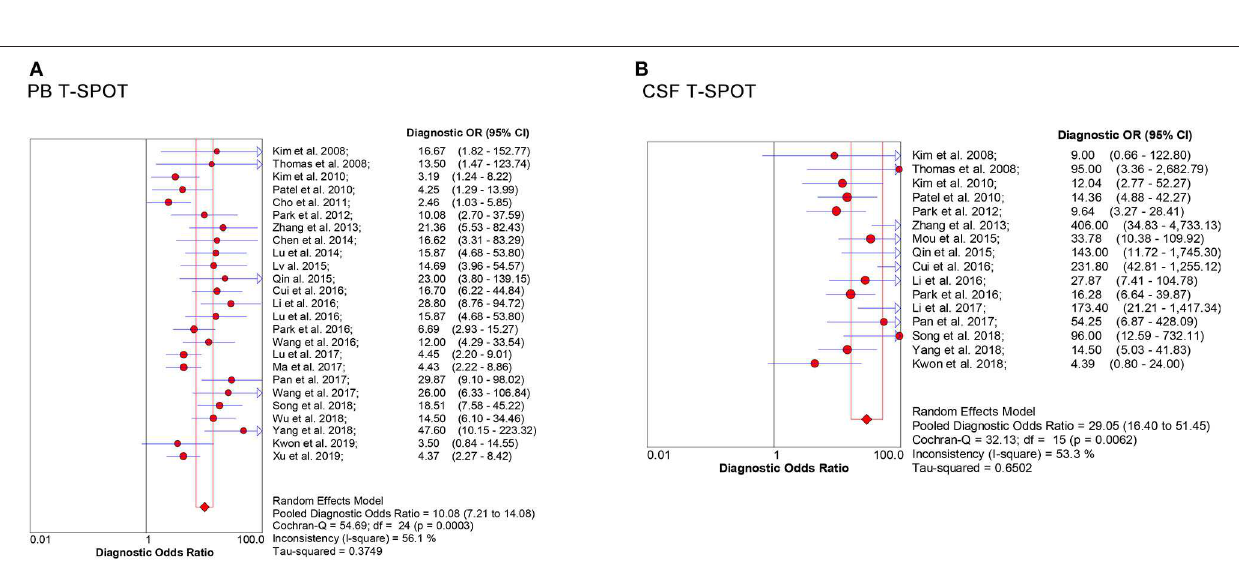
FIGURE 5 | Forest plot of estimates of DOR for (A) PB T-SPOT and (B) CSF T-SPOT for the diagnosis of TBM. Point estimates of DOR from each study are shown as solid dots whose size reflects the total number of cases and controls. Error bars show 95% CI. DOR, diagnostic odds ratio; PB, peripheral blood; CSF, cerebrospinal fluid; TBM, tuberculous